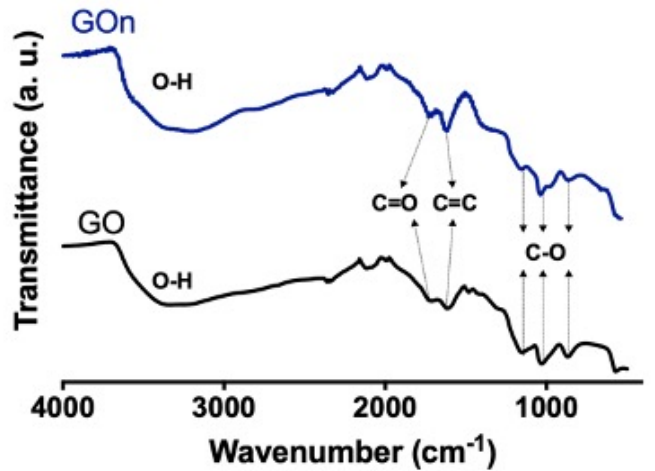
Figure 6. FTIR spectra of GO (black line) and GOn (blue line), showing the contribution of surface functionalities.